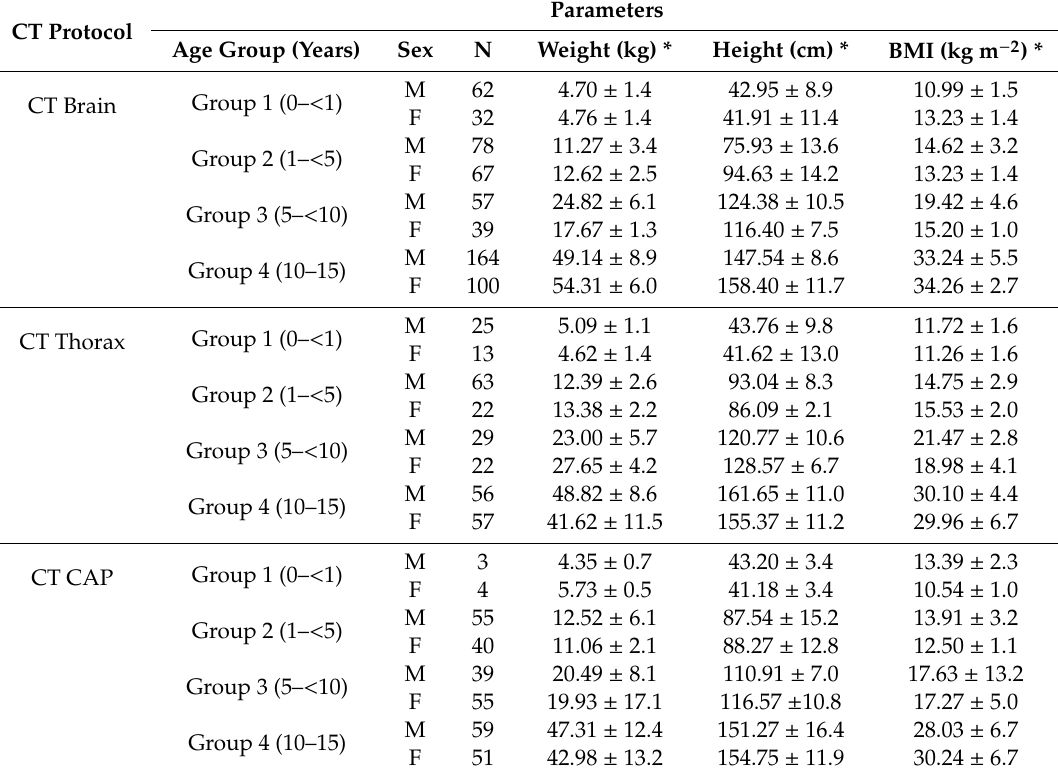
Table 1. Patient characteristic distribution of CT brain, thorax and CAP by sex and age groups.